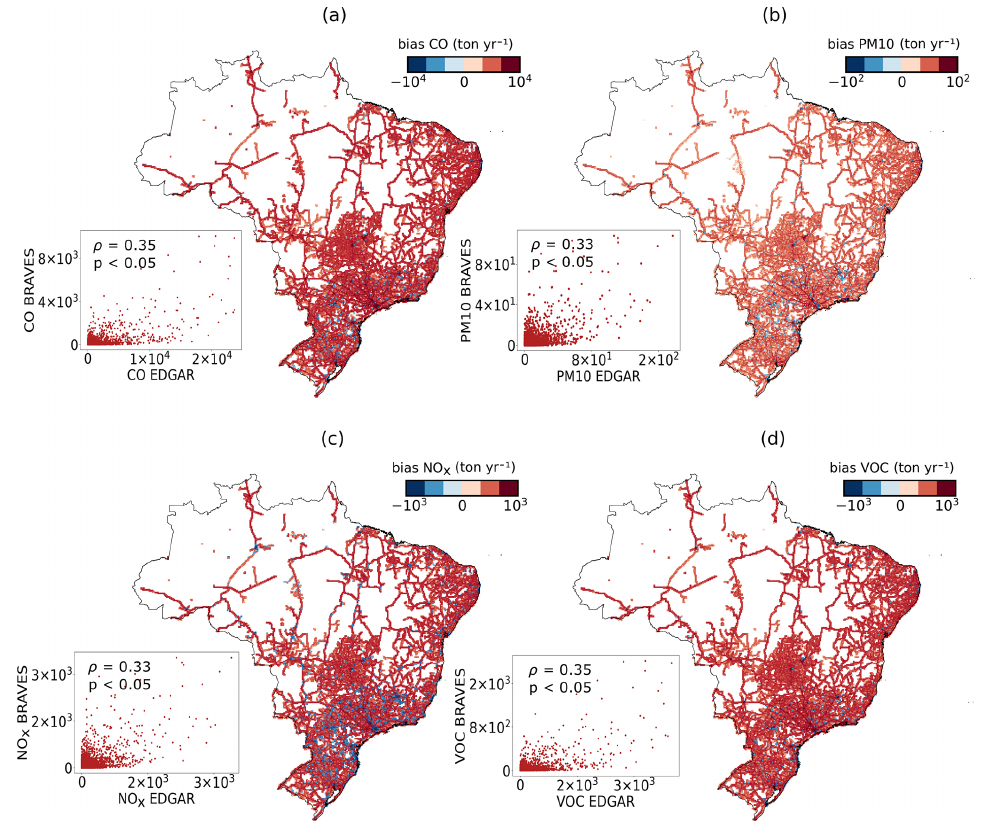
Figure 9. Bias (log scale) and scatter plots of (a) CO, (b) PM 10 , (c) NO x , and (d) VOC emission rates provided by the BRAVES database and EDGAR in